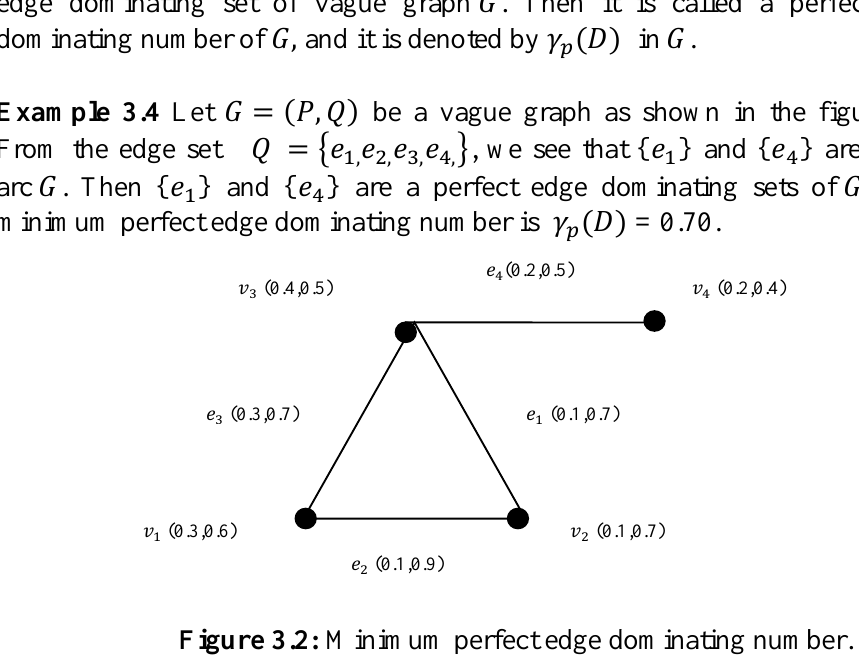
Figure 3.2: Minimum perfect edge dominating